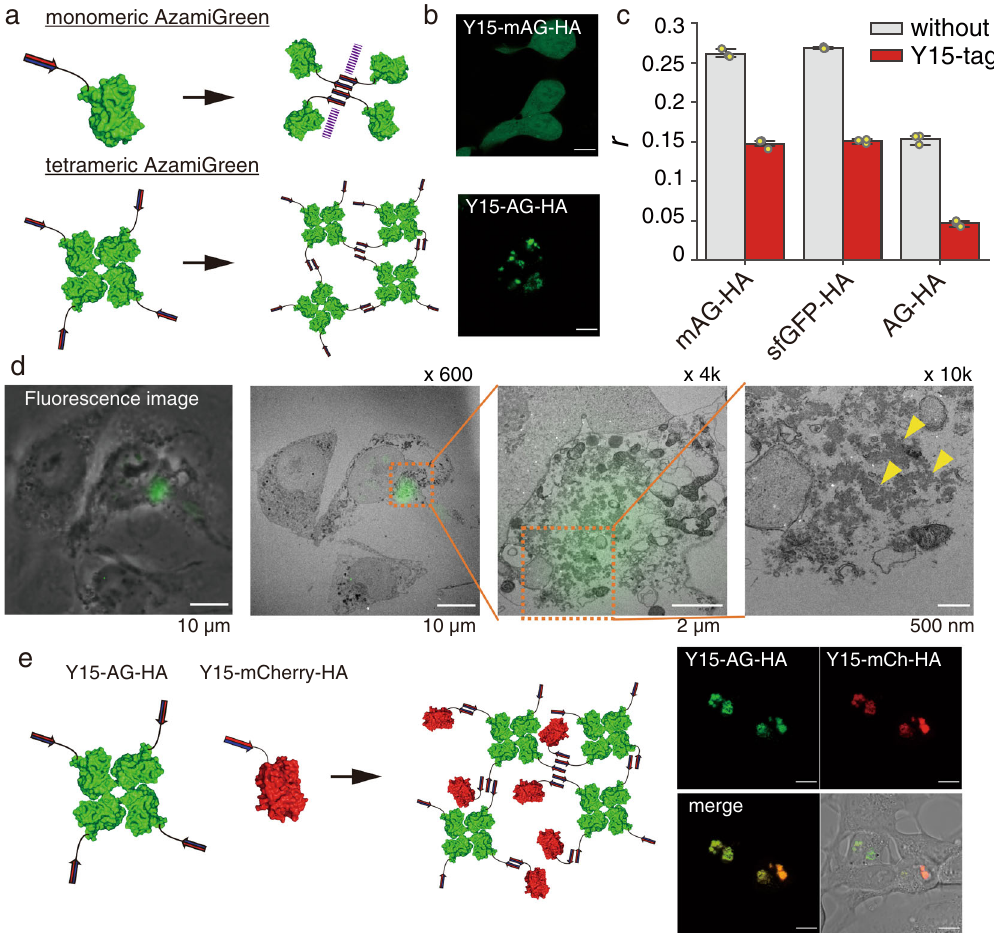
Fig. 4 Engineering of protein aggregates by combining Y15 self-assembly and protein – protein interactions. a Schematic illustration of the assembly of Y15-tagged monomeric AG and tetrameric AG. b Fluorescence images of HEK293 cells expressing Y15-mAG-HA and tetrameric Y15-AG-HA. Scale bar, 10 µ m. c Fluorescence anisotropy measurements of transfected HEK293 cells ( n = 3 biologically independent experiments). Data are presented as mean values + / − SD. Source data are provided as a Source data fi le. d Correlative light and electron microscopy of Y15-AG expressing COS-7 cells, fl uorescence image (left panel), overlay of the images (2nd and 3rd panels) and a higher magni fi cation TEM image (right panel). Granular structures were not surrounded by membranes (arrowheads). e Fluorescence observation of co-transfected cells with Y15-AG-HA and Y15-mCherry-HA. Scale bar, 10 µ